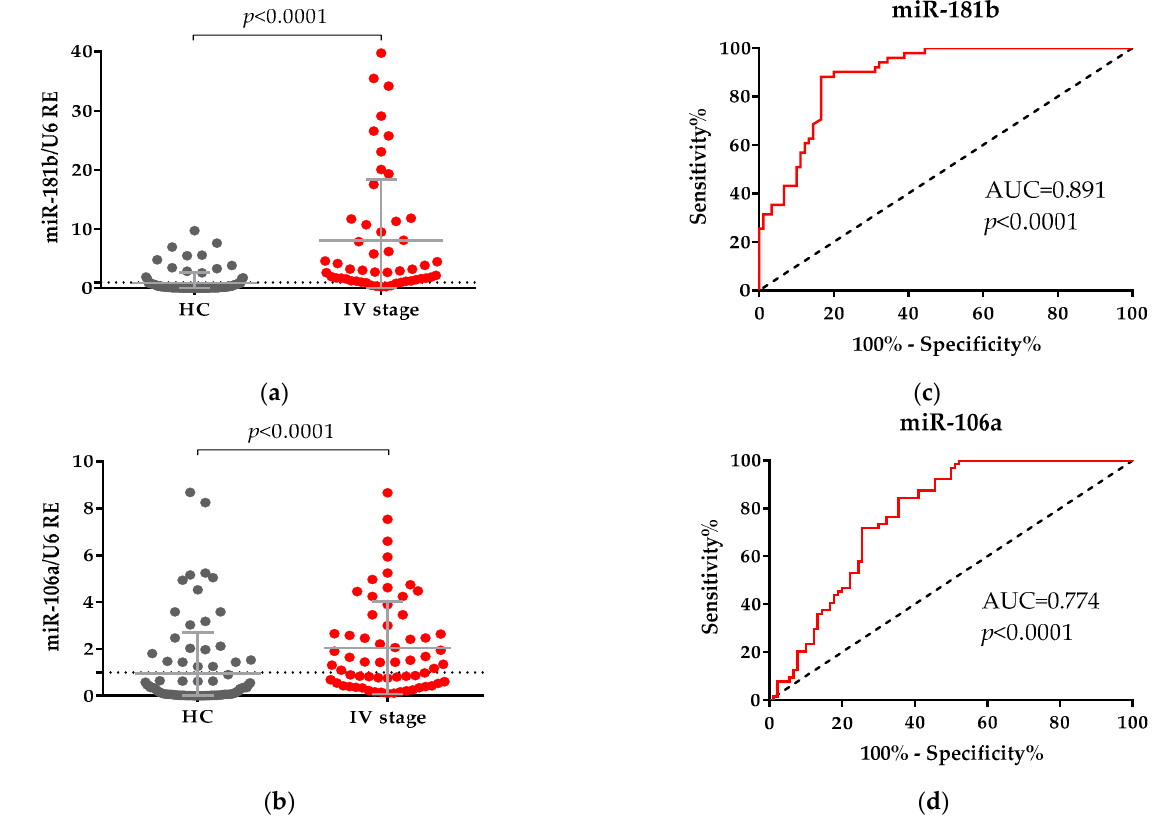
Figure 5. Comparison between levels of ( a ) miR-181b and ( b ) miR-106a in plasma samples from healthy controls (HC) and patients with CRC in stage IV. The expression levels of both miRNAs were measured using qPCR in plasma from CRC patients and HC. U6 RNA was used as an internal control. Relative gene expression (RE) was calculated using the 2 −∆∆ Ct method. The Mann–Whitney U test was used to compare the two groups—HC and CRC patients; data are presented as mean ±SD. ROC curves of ( c ) miR-181b and ( d ) miR-106a used to differentiate patients with metastatic CRC from HC.